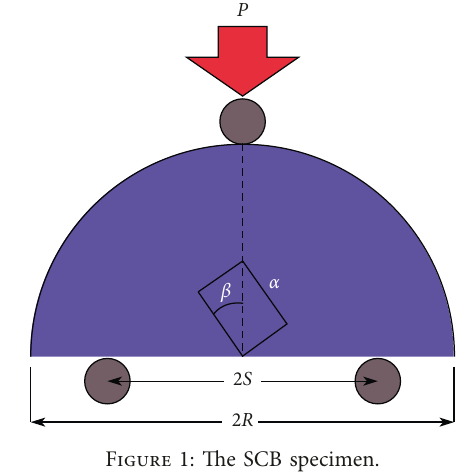
Figure 1: The SCB specimen.